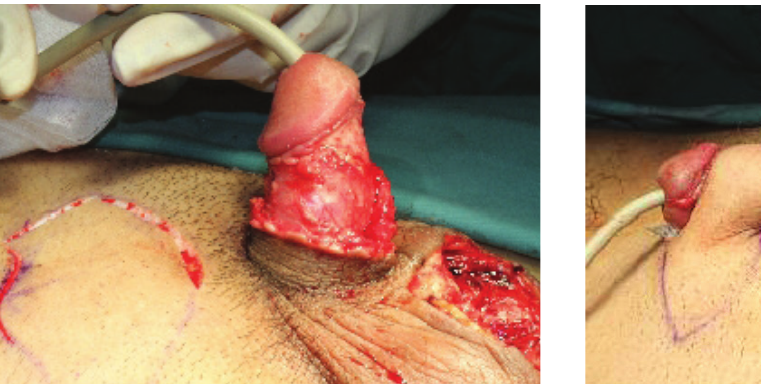
Figure 4 - Exposed penile shaft buried under a large random pattern flap over the midline raphe of the